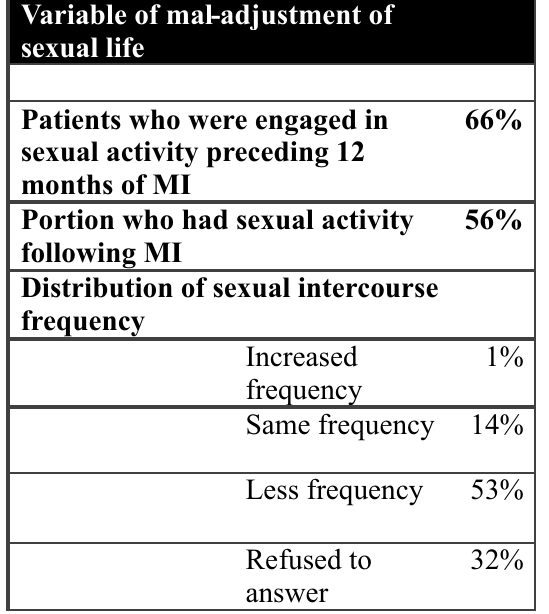
Table 04. Distribution of sexual mal- adjustment in post MI study